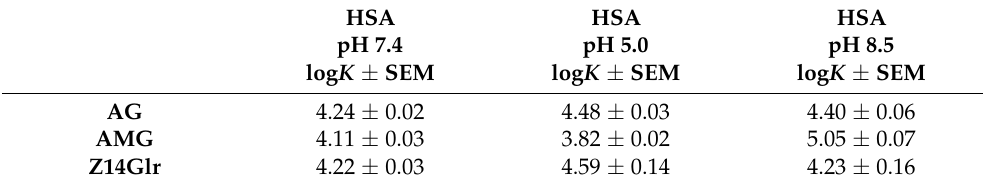
Table 3. Decimal logarithmic values of binding constants ( K ; L/mol) of mycotoxin–albumin com- plexes, determined based on ultracentrifugation experiments ( n =